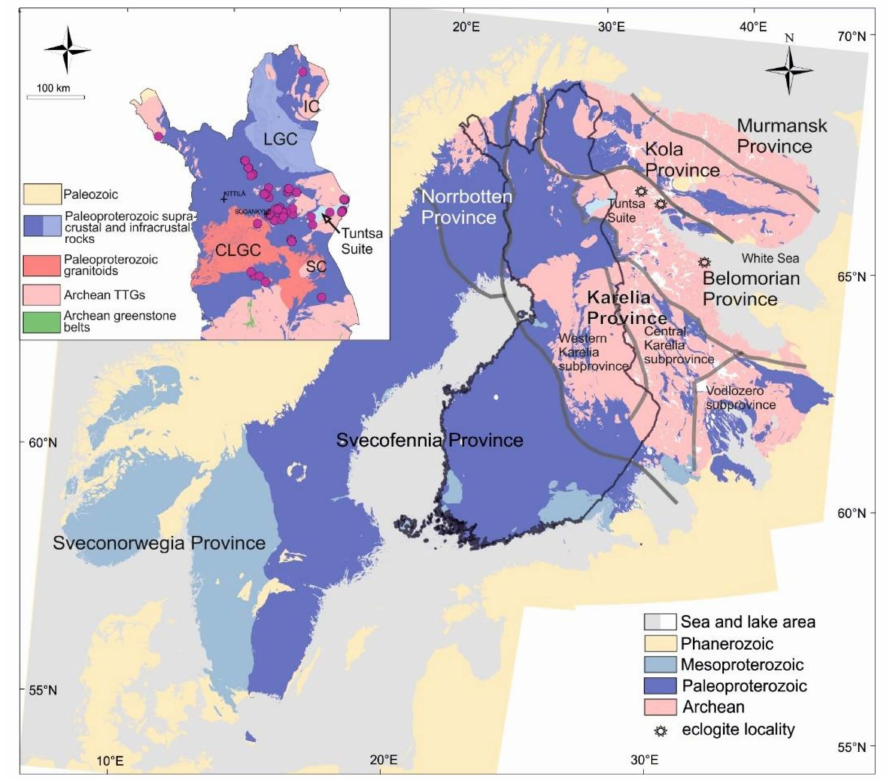
Figure 1. Generalised geological map of the Fennoscandian Shield, simplified from the Geological Map of the Fennoscandian Shield 1:1,000,000 (Electronic resource), Espoo, Geological Survey of Finland (fennoscandia_geology_fin_1m.xml). The land area of Finland is outlined. The Tuntsa Suite is marked with light blue. Eclogites in the Belomorian Province are marked with stars. The inset is a simplified geological map of northern Finland, the red dots show the locations of kyanite-bearing rocks. IC = Inari Complex, LGC = Lapland Granulite Complex, CLGC = Central Lapland Granulite Complex, SC = Suomujärvi Complex. The province boundaries are modified from Nironen [17] and Hölttä et al.